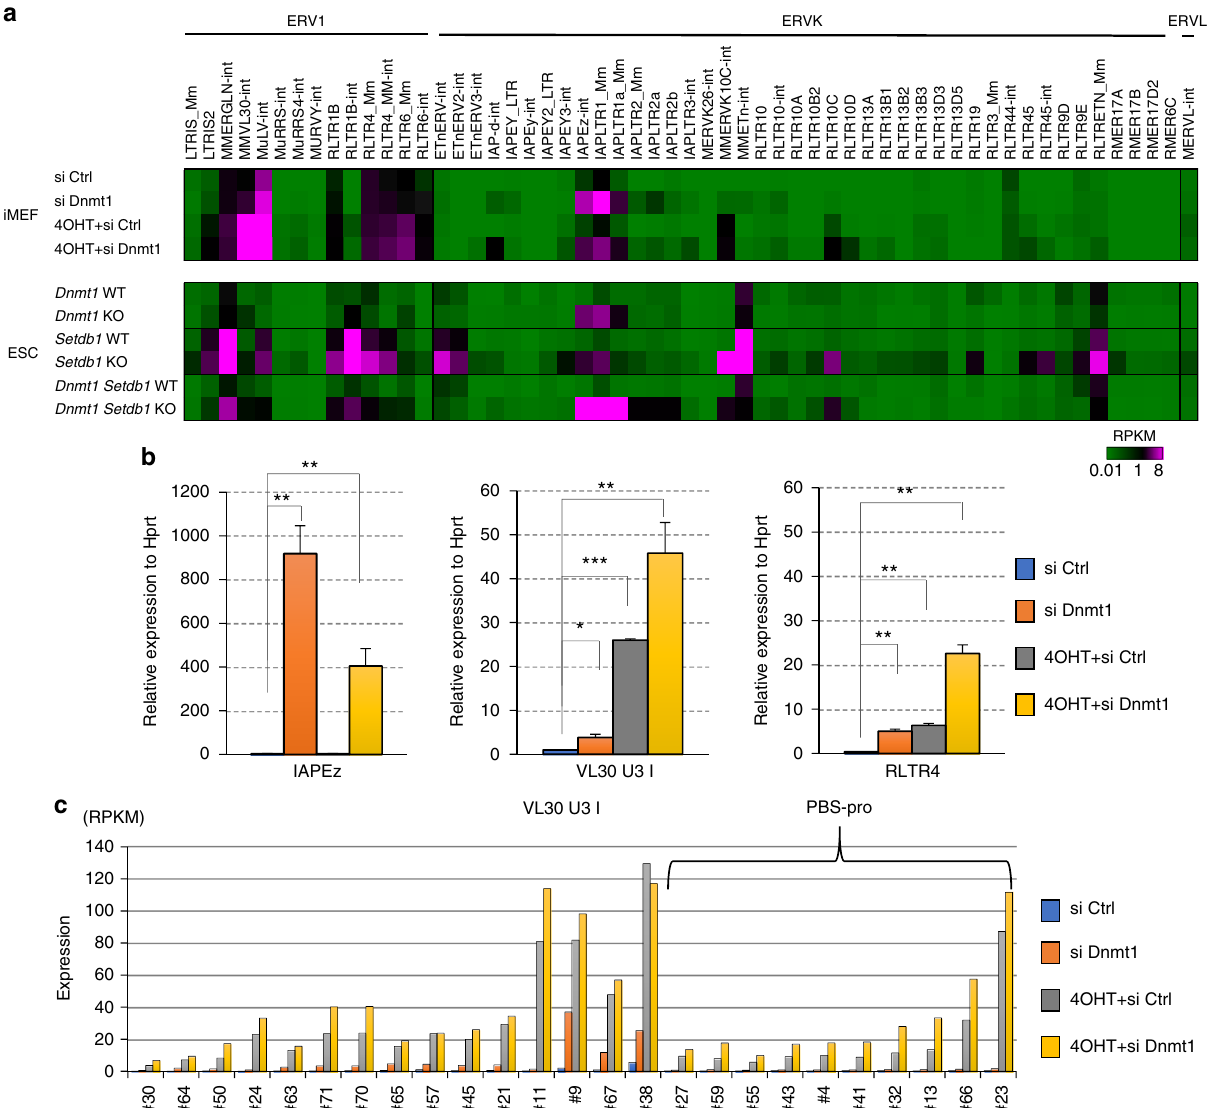
Fig. 4 Dnmt1 and Setdb1 are required for the silencing of distinct sets of ERVs. a Expression of ERV families by the loss of Dnmt1, Setdb1, and simultaneous depletion of Dnmt1 and Setdb1 in iMEFs and ESCs. To obtain mRNA-seq data of iMEFs, Setdb1 cKO iMEFs were transfected with siRNA against Dnmt1 or control siRNA in combination with or without Setdb1 depletion by the 4OHT treatment, then mRNA was isolated. RNA-seq data from Dnmt1 cKO or double cKO of Dnmt1 and Setdb1 ESCs (6 days after treatment of 4OHT or without treatment) 36 were reanalyzed. Heatmap indicates the magnitude of the RPKM value. b Setdb1 cKO iMEFs were transfected with siRNA against Dnmt1 either alone or in combination with the loss of Setdb1. RT-qPCR of VL30 U3 class I RLTR6, IAPEz, and RLTR4 was performed. Values represent mean expression relative to VL30 U3 I control ( n = 2 biological replicates). Error bars represent s.d. *0.005 < P < 0.05, **0.0005 < P < 0.005, *** P < 0.0005, Student ’ s t -test. c The derepression induced by Dnmt1 KD, Setdb1 KO, and